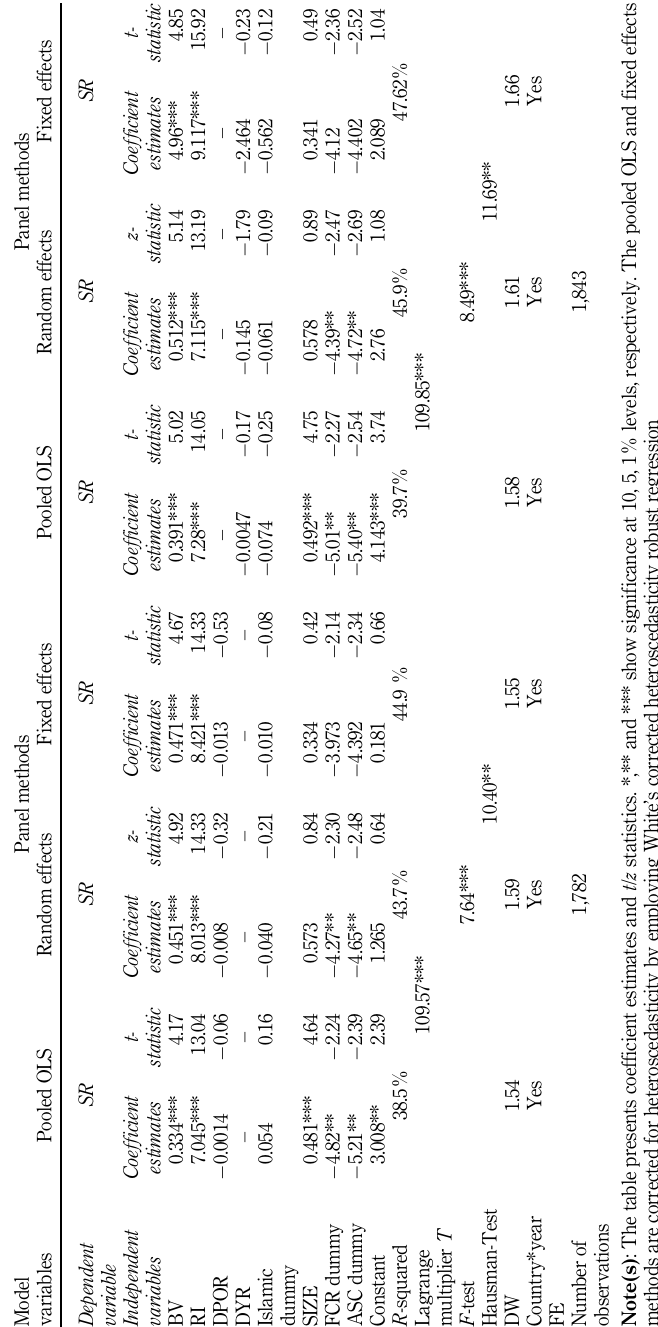
Table 6. Findings of the Ohlson (1995) model applied to banks in MENA